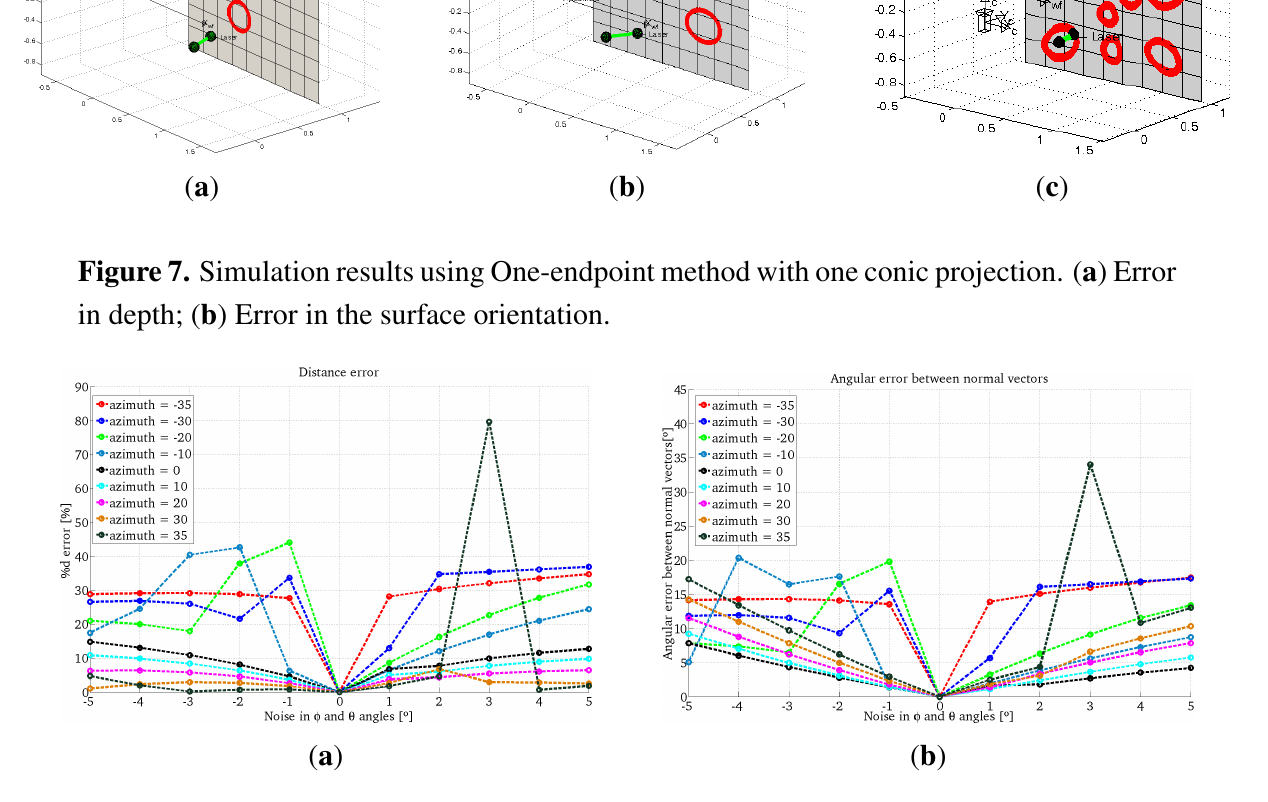
Figure 8. Simulation results using Two-endpoint method with one conic projection. ( a ) Error in depth; ( b ) Error in the surface